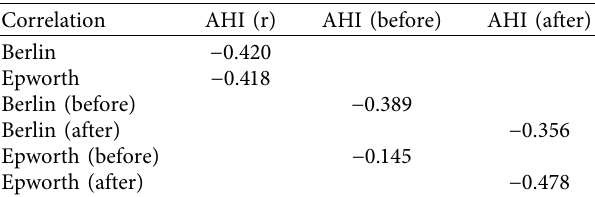
Table 2: Correlations between total AHI/hr and the BQ and the ESS scores.